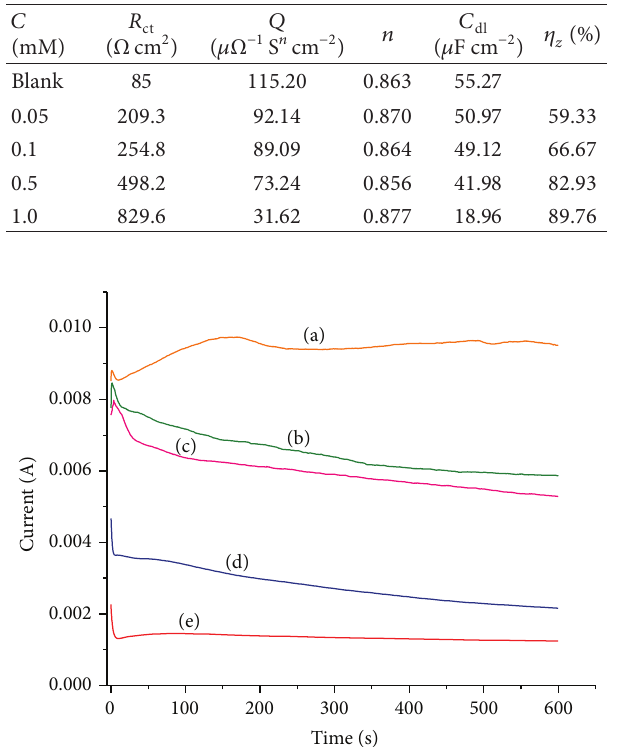
Table 5: Electrochemical impedance parameters of mild steel in 1M HCl containing different concentrations of RS.